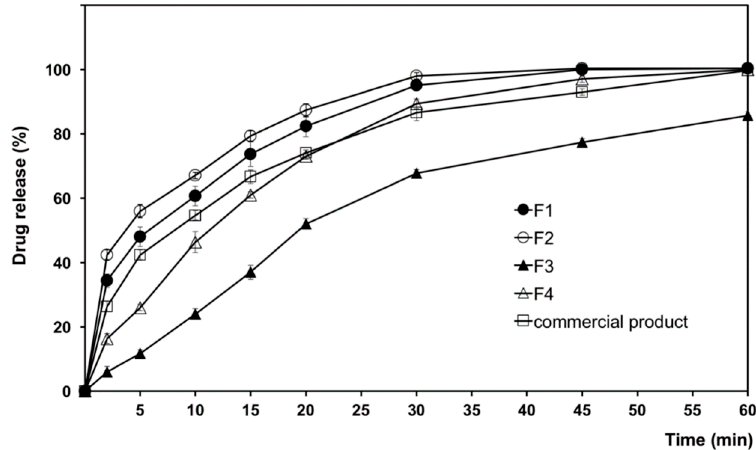
Figure 8. Dissolution profiles of albendazole SMEDDS chewable tablets (F1–F4) and a commercial albendazole tablet in 0.1 N HCl medium pH 1.2.